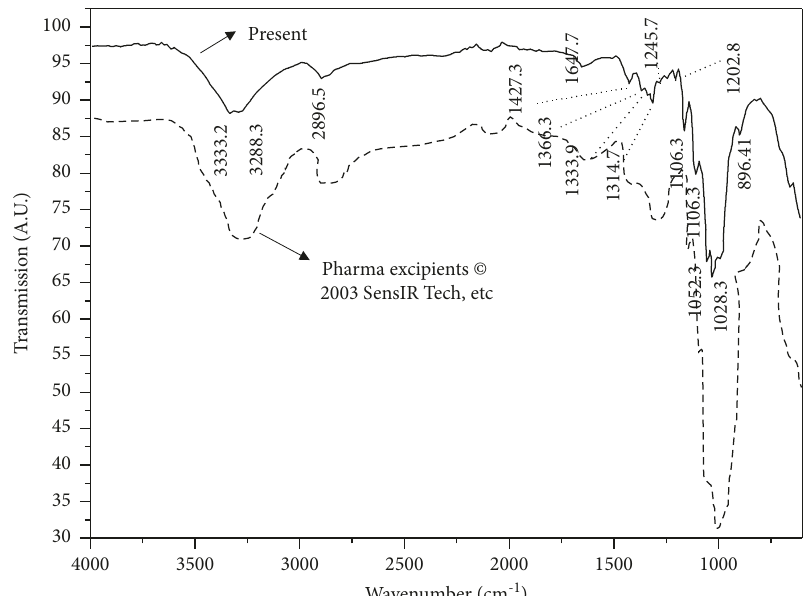
Figure 6: FT-IR result of the synthesized film: solid line represents measured data; its y -value is in accordance with the y -axis; the dashed line represents a reference data (a commercially available cellulose powder/fiber) while its y -value is not to scale (The raw data are available in the supplementary file (available (here))).